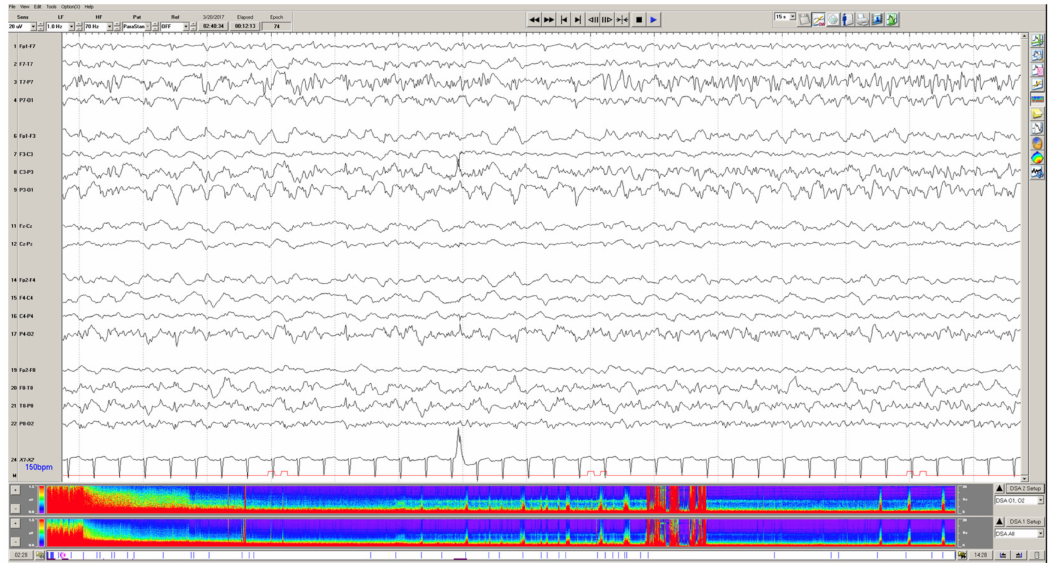
Figure 1. Status epilepticus in a 7-year-old male with no neurologic premorbidity, cannulated to VA ECMO for respiratory failure and shock. The EEG above demonstrates the left posterior quadrant focal status epilepticus. The density spectral array (color panel at the bottom) illustrates subsequent seizures during this 12-h recording epoch as denoted by red peaks throughout the